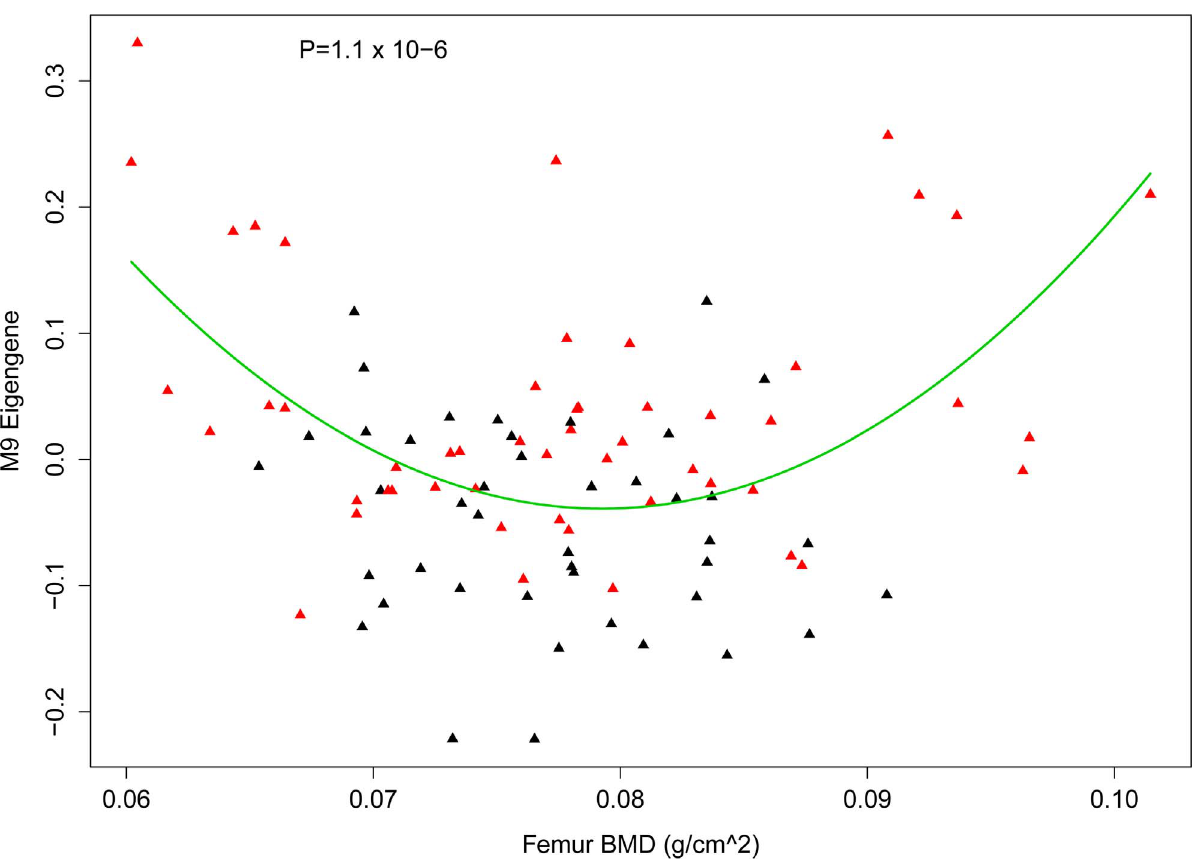
Figure 7. Nonlinear association between the M9 eigengene and BMD. Plot showing the relationship between the M9 eigengene and femur BMD in the HMDP. A quadratic model (M9 eigengene=BMD + BMD ‘ 2) significantly (P=1.1 6 10 2 6 ) fit the data. The quadratic line is shown in green. Each diamond represents a strain and those in red are homozygous ‘TT’ and those in black are homozygous ‘CC’ at rs3303926 SNP that regulates Sfrp1 expression and the M9 eigengene.